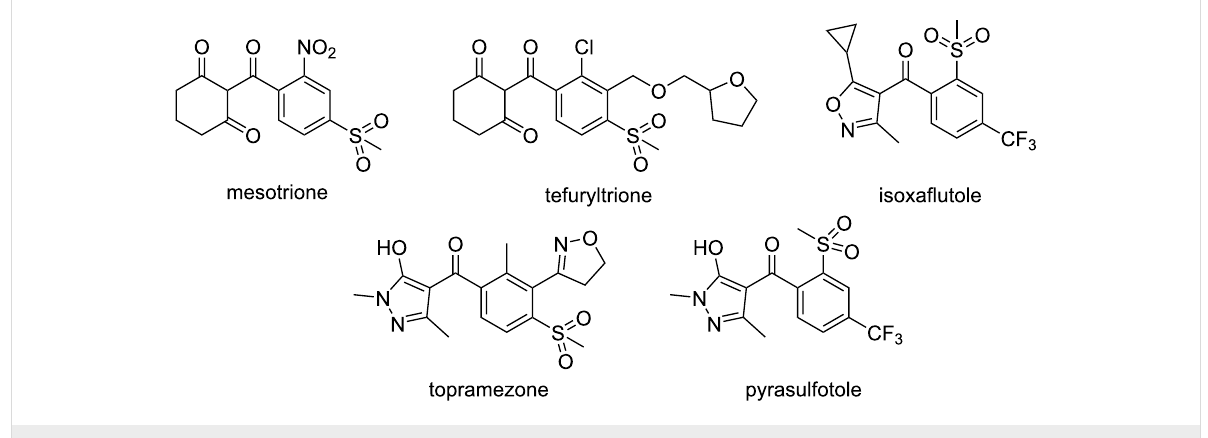
Figure 1: Chemical structures of the commercial HPPD inhibitors.